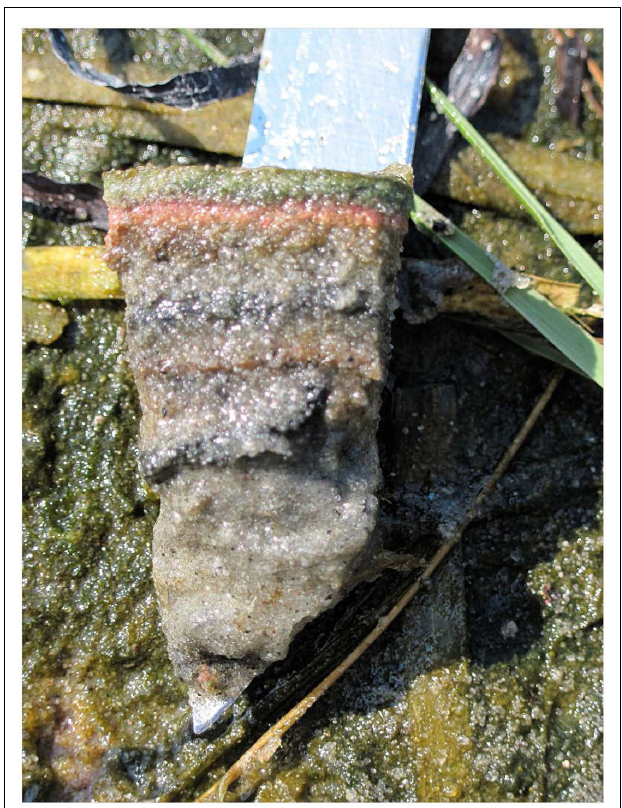
FIGURE 1 | Greater Sippewissett salt marsh microbial mat showing typical lamination (photo credit: NDY).